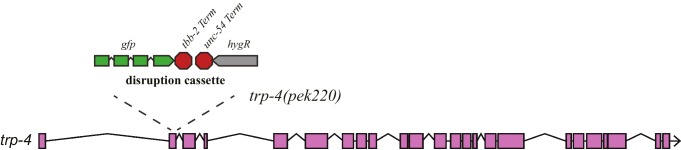
The design strategy for a trp-4 allele (pek220).A disruption cassette that contains gfp::tbb-2utr and Prps-0::hygR::unc-54utr was inserted into trp-4 exon 2, which results in a deletion and an early stop codon that put trp-4 out-of-frame after the amino acid residue 53.